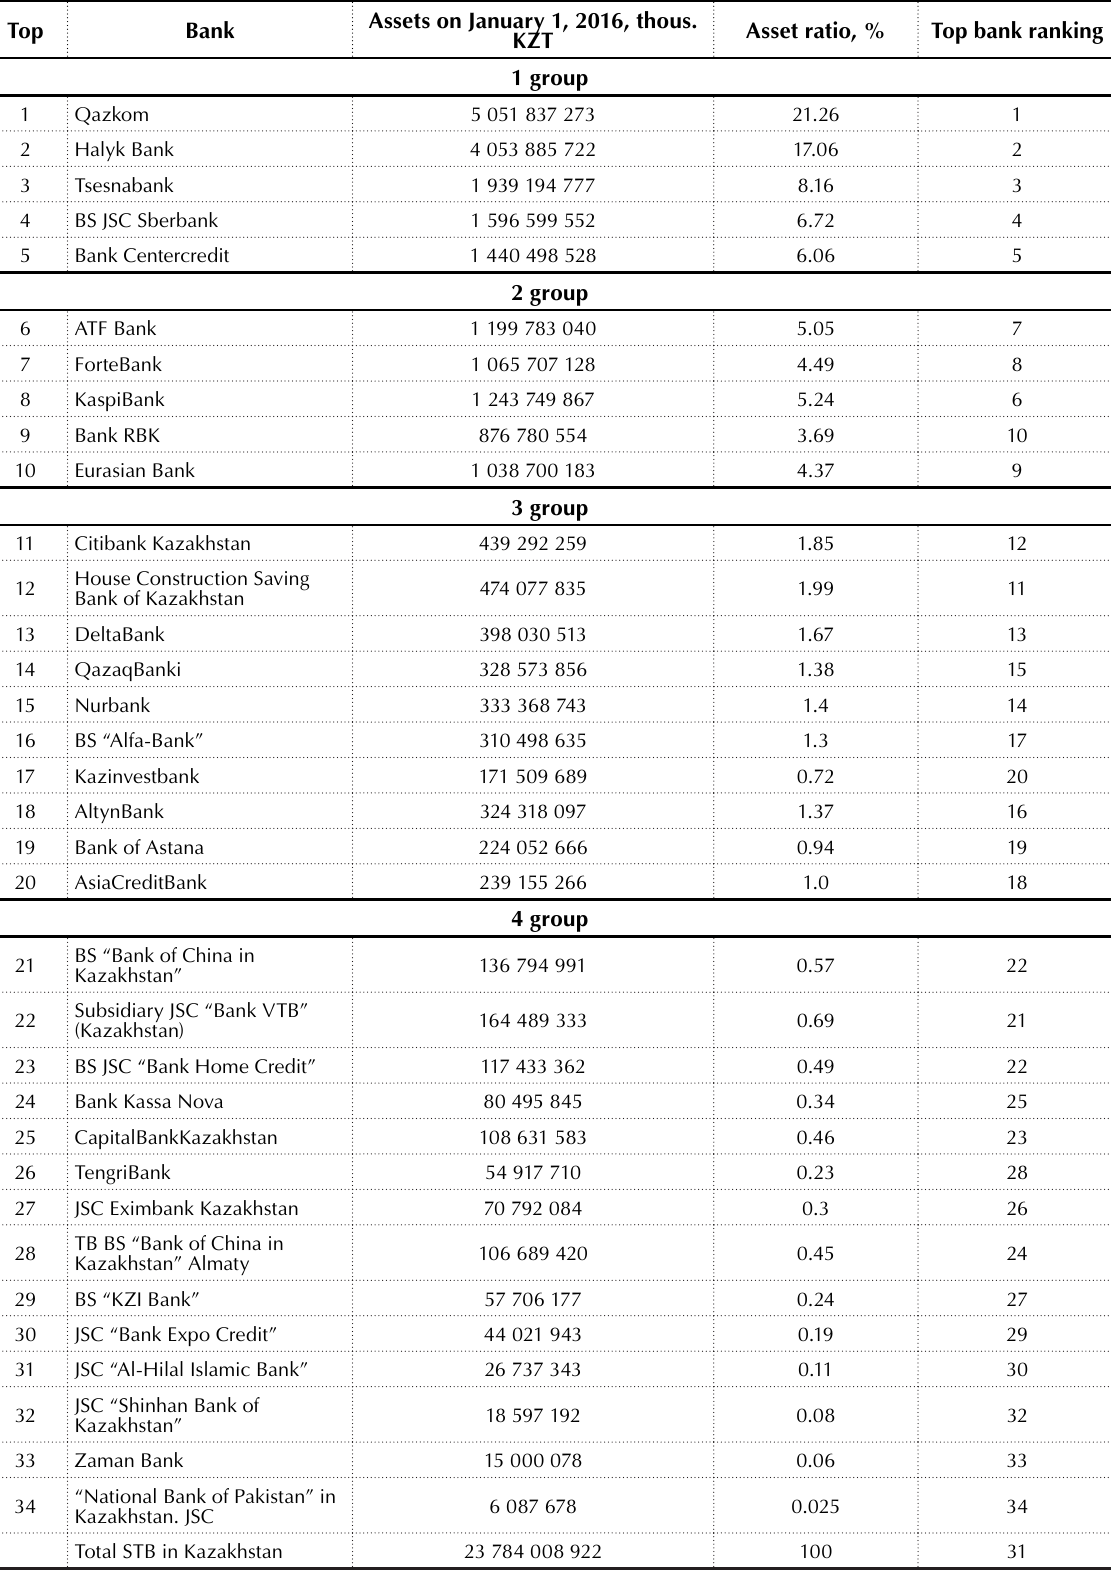
Table 4. Economic assessment of Kazakhstan bank ranking in the context of asset on January 1, 2016 Assets on January 1, 2016, thous. Top Bank Asset ratio, % Top bank KZT